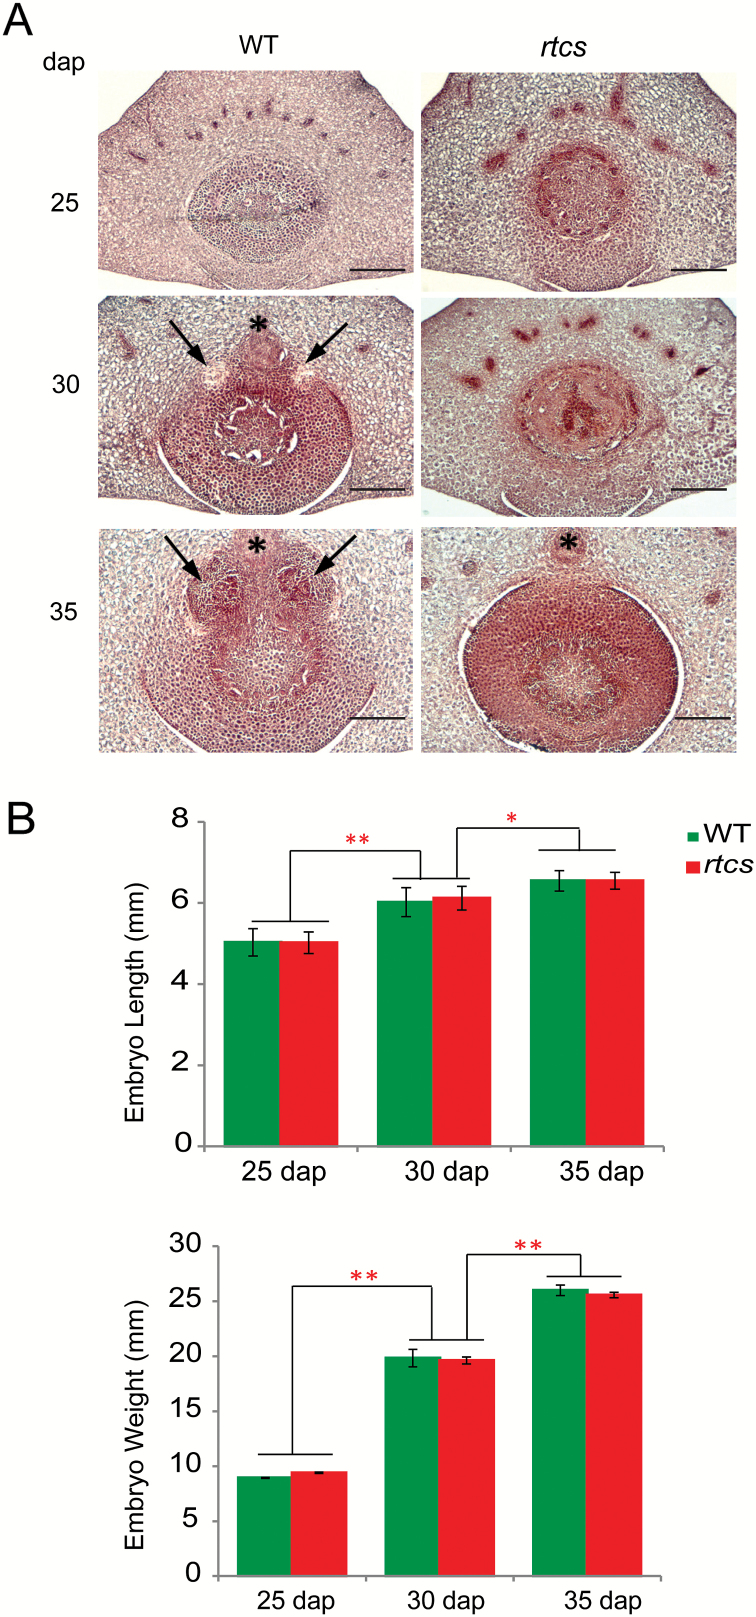
Histological and phenotypic analyses of wild-type (WT) and rtcs embryos during formation of seminal root primordia at three developmental stages. (A) Transverse sections of Safranin-/Fast Green-stained WT and rtcs embryos 25, 30, and 35 d after pollination (dap). Seminal root primordia are indicated by black arrows. The main strand of the scutellar bundle is indicated by black asterisks. Scale bars are 300 µm. (B) Quantification of embryo length and weight in WT and rtcs at 25, 30 and 35 dap. *, P<0.01; **, P<0.001; n=10; error bars indicate ±SD.